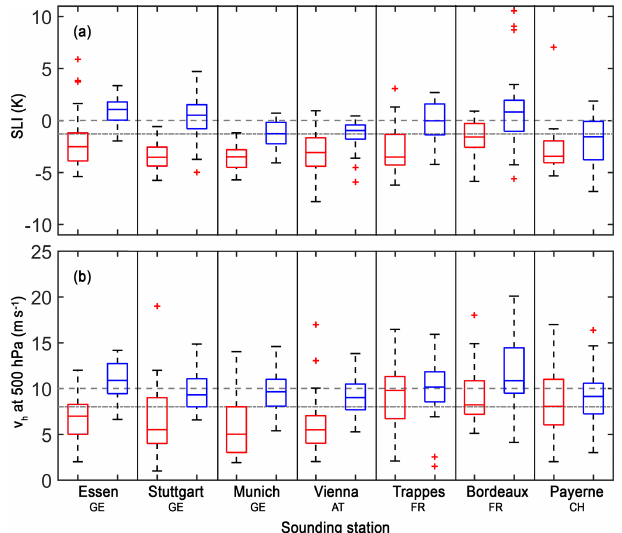
Figure 14. Box-and-whisker plots (median, first and third quar- tiles, whisker = ± 2 . 7 σ , outliers) for the seven sounding stations. The left-hand box plots (in red) of each station include all values of (a) SLI and (b) V 500 during the study period at 12:00UTC, the right-hand box plots (in blue) include the annual minimum of the running mean (22d) during May and June between 1981 and 2010. The two grey lines indicate thresholds as defined in PIP16 (basic criterion: 0K and 10ms − 1 ; strict criterion: − 1 . 3K and 8ms − 1 ; see Sect. 2.6). Note that the median on the left-hand box plots is calculated identically to all 30 values in the right-hand box